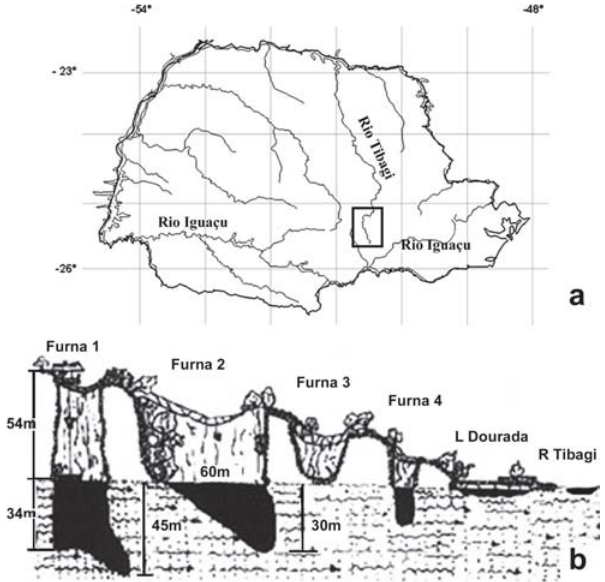
Fig. 1. Collecting sites of Astyanax aff . fasciatus in the upper rio Tibagi region, Paraná, Brazil (a). Geological profile of the Furnas and Lagoa Dourada in relation to the rio Tibagi (b).